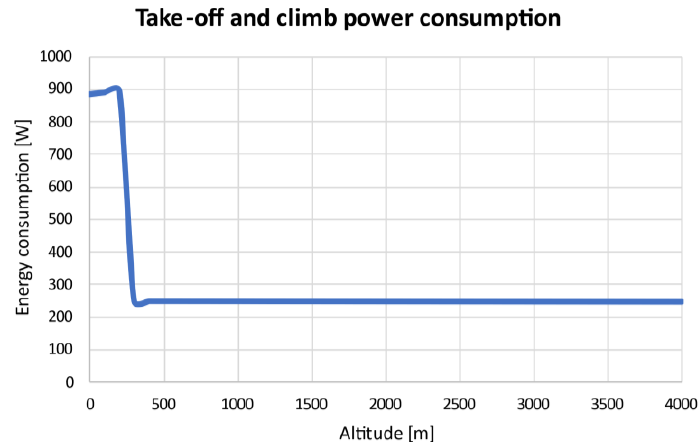
Figure 8. Energy consumption during take-off and climbing.